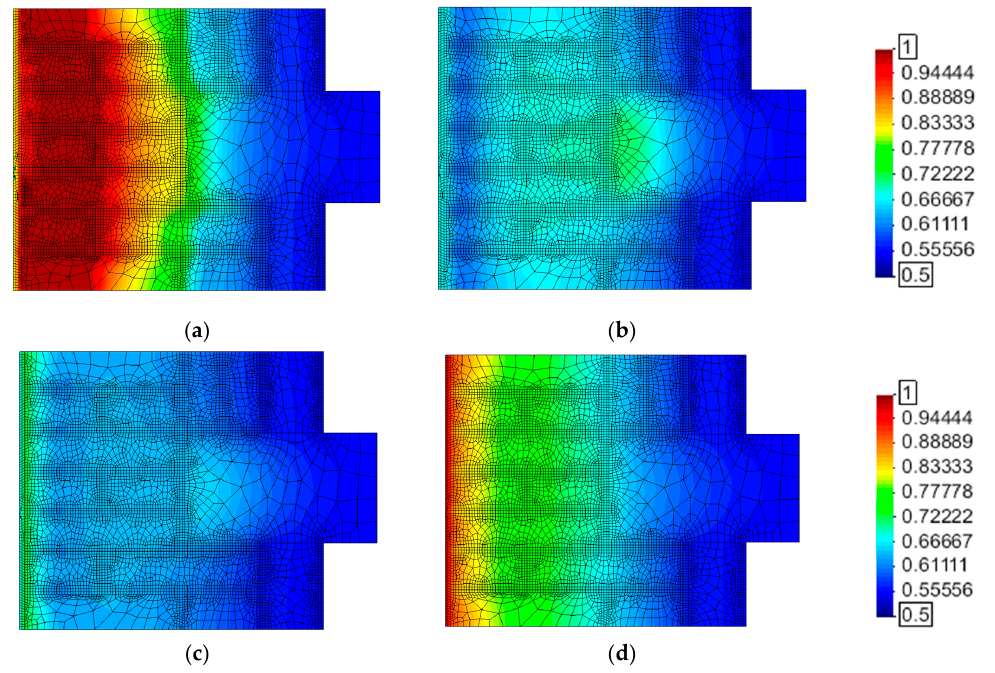
Figure 12. Relative humidity distribution (-) over the masonry and wooden beam end provided with interior thermal insulation made of mineral wool: ( a ) 9 January, 16:00, ( b ) 10 April, 22:00, ( c ) 11 July, 11:00, and ( d ) 10 October, 10:00. The relative humidity values were obtained using computational modeling technique described in Section